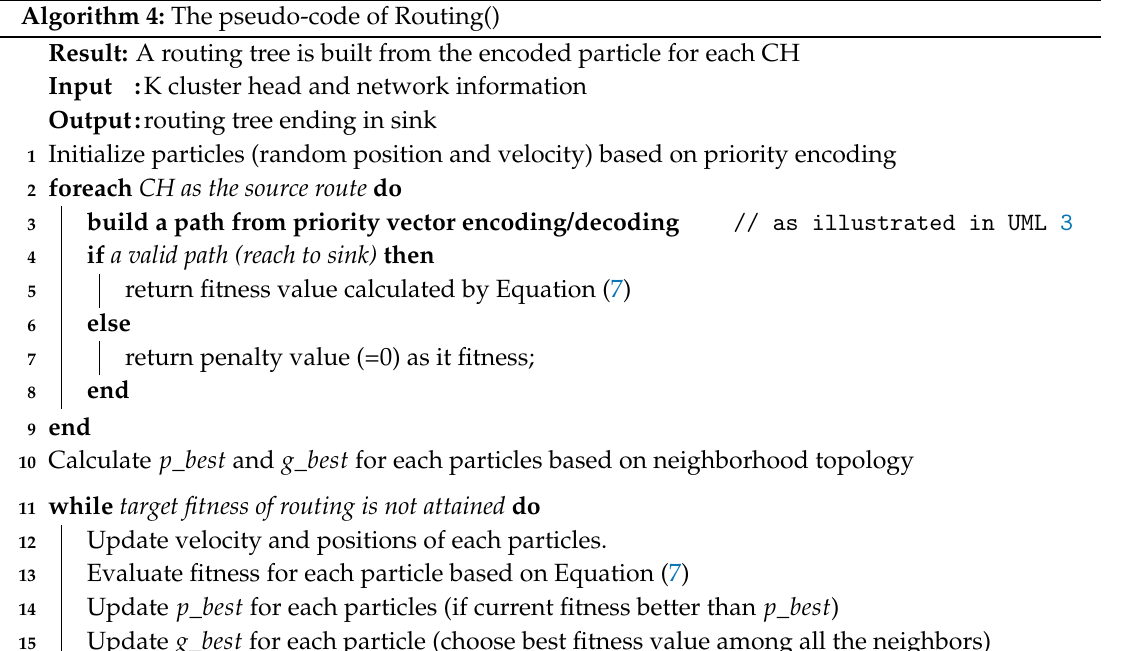
Algorithm 4: The pseudo-code of